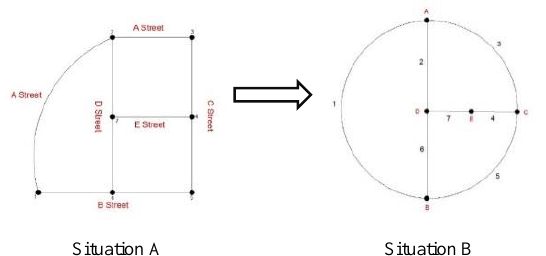
Situation A Figure 2. Converting the major graph-situation A to dual graph-situation B